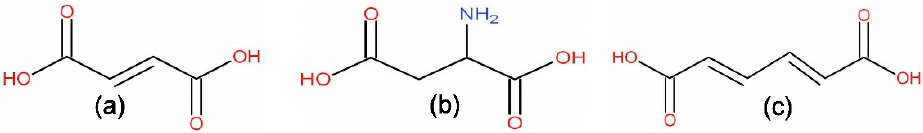
Figure 1. ( a )-fumaric acid; ( b )-aspartic acid; ( c )-muconic